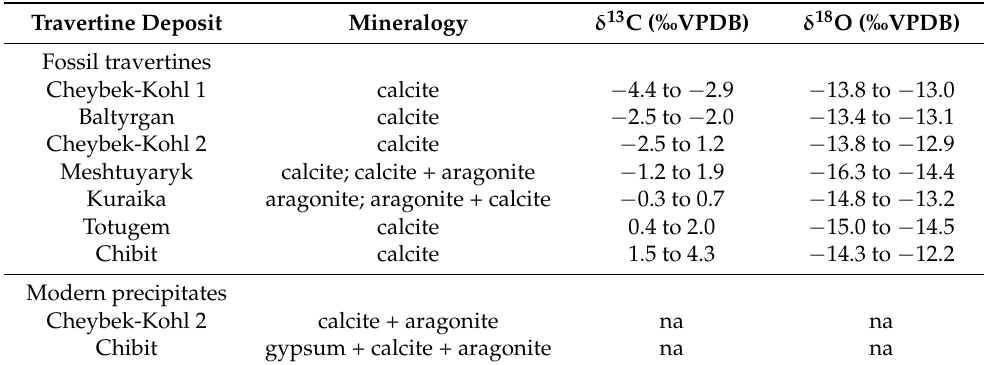
Table 2. Stable isotope composition of CaCO 3 and mineralogy of fossil travertines and modern precipitates from the south-eastern Gorny